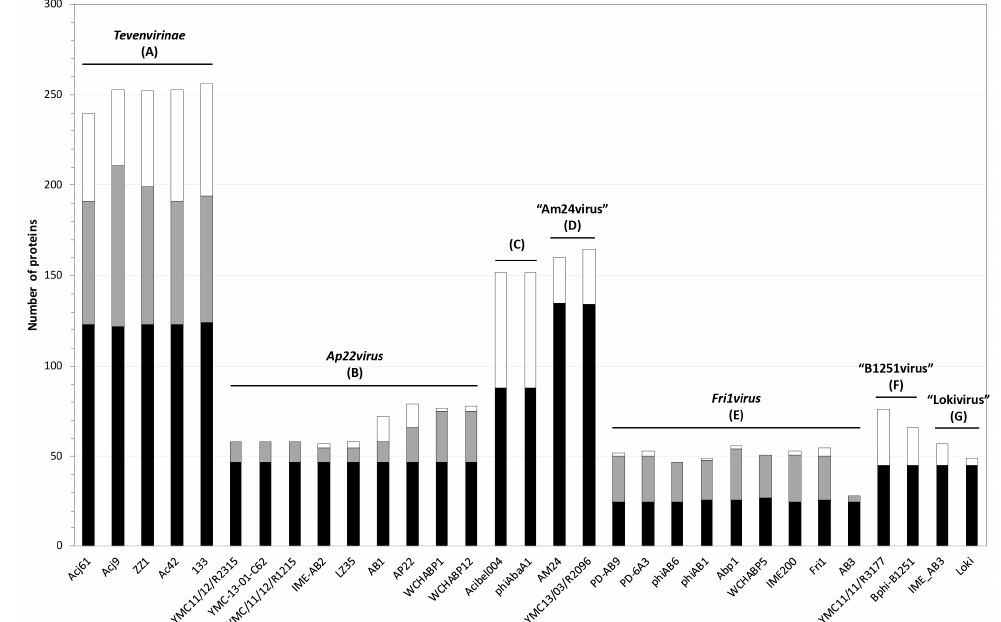
Figure 3. Summary of core, accessory and unique protein groups of individual phage clusters. Core proteins, those encoded by all phages within a cluster, are shown in black. Accessory proteins, those present in two or more but not all phages within a cluster, are shown in grey while unique proteins are shown in white. Clusters comprised of just two phages have no accessory protein count. Phages designated as genomic singletons are not displayed. Clusters corresponding to existing ICTV/proposed genera have been labelled.